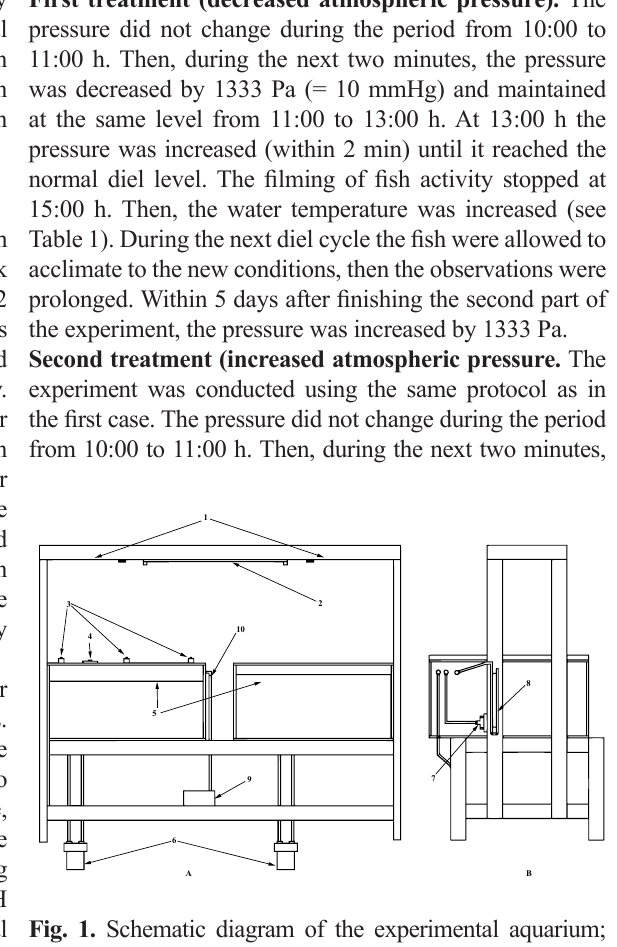
Fig. 1. Schematic diagram of the experimental aquarium; front view ( A ), side view ( B ), 1 = video cameras, 2 = light source, 3 = glass clips, 4 = technical opening, closed by gum cover with a clip, 5 = water level , 6 = external filters , 7 = ball valve, regulating the pressure over the water, 8 = barometer, 9 = compressor for pressure pumping over the water, 10 = cover glass (20 mm